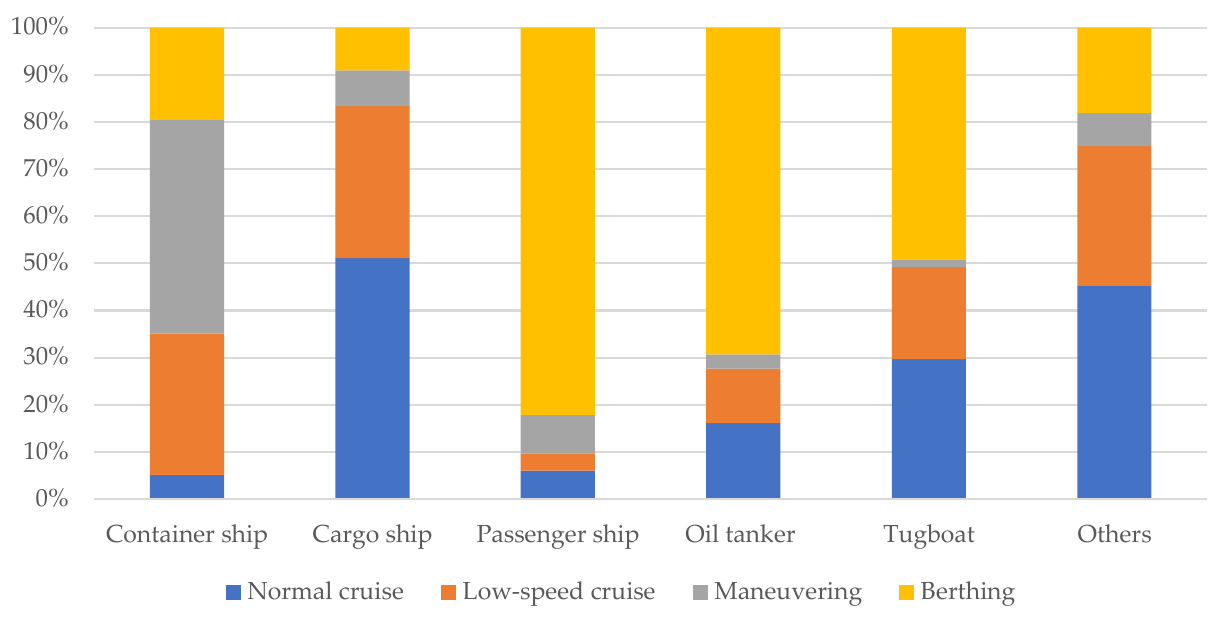
Figure 13. Comparison of PM₁₀ emissions in different sailing states.